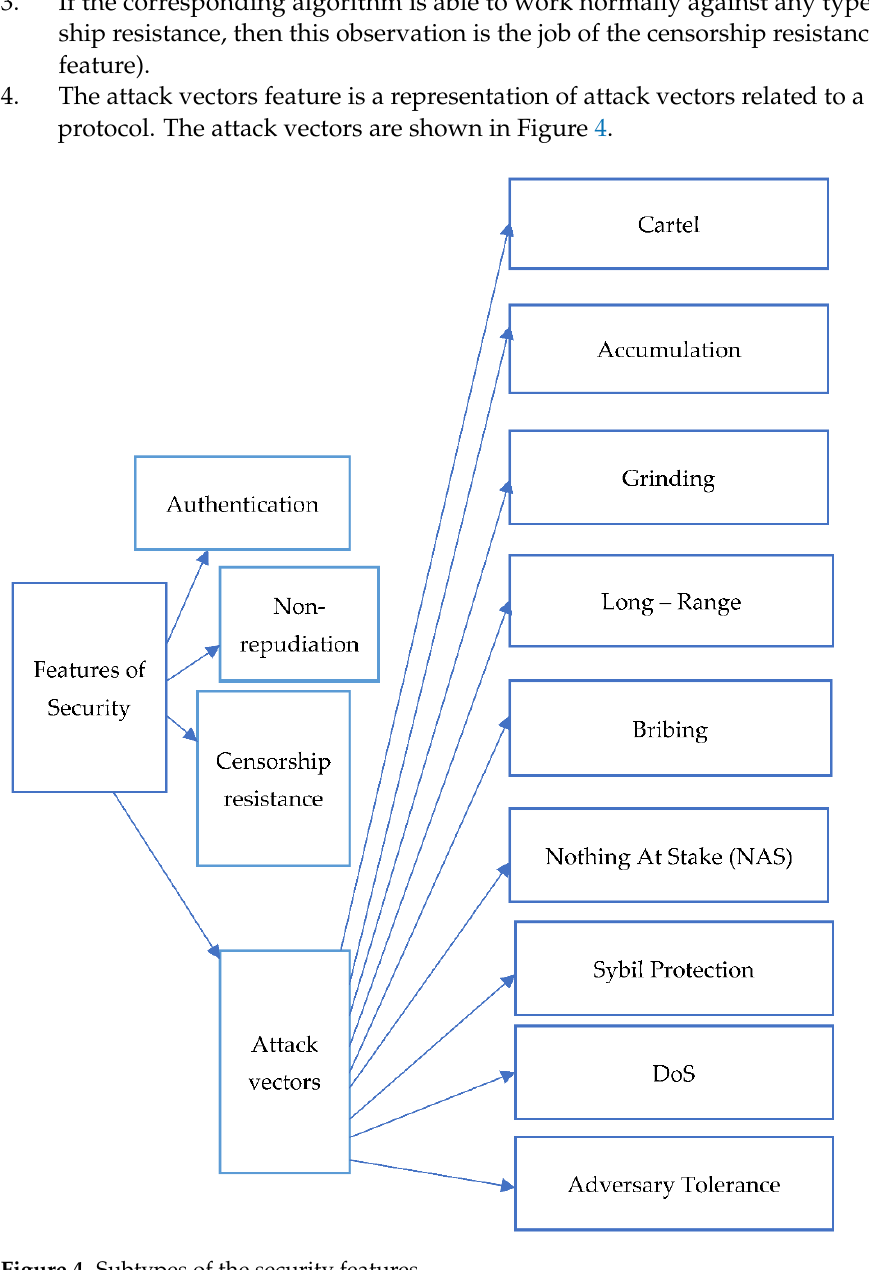
Figure 4. Subtypes of the security features.